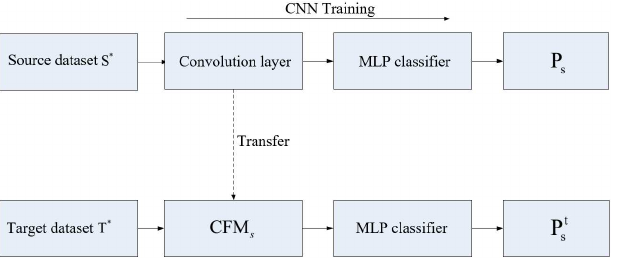
Figure 1. The experimental structure diagram of generalization ability of feature mapper